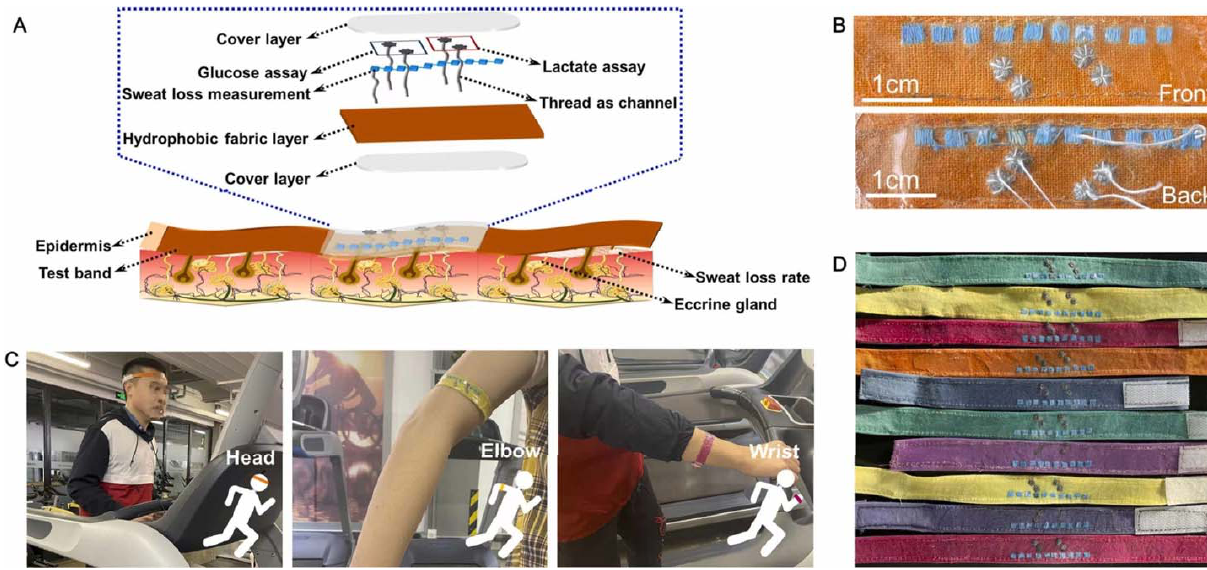
Figure 20. ( A ) Exploded view illustration of a thread-embroidered/fabric sensing band and its interface with the skin. ( B ) Front view and back views of the band. ( C ) The band can serve as a wearable device deployed on regions of the human body with different curvatures and shapes, e.g., head, elbow and wrist. ( D ) Optical images of flexible, wearable thread-embroidered/fabric microfluidic devices for sweat sensing and monitoring. Reproduced with permission from